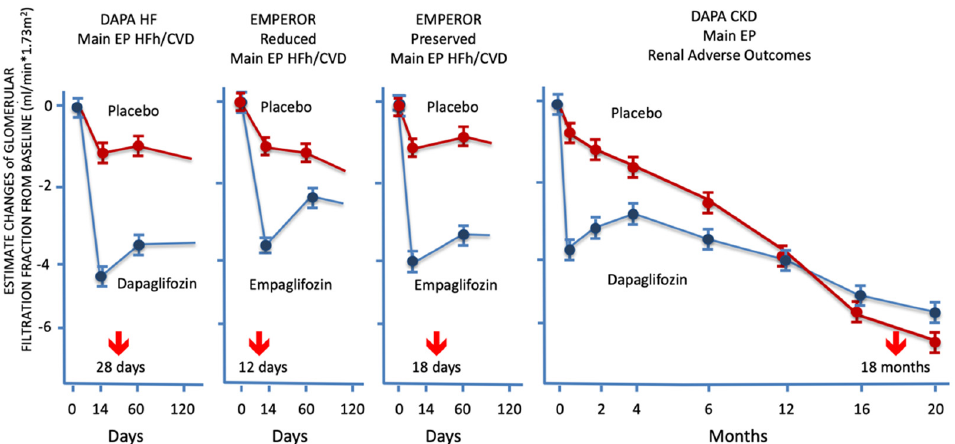
Figure 4. The figure depicts the temporal relationship between the detection of the statistically significant achievement of the primary end-point of DAPA HF [28], EMPEROR-Reduced [29], EMPEROR-Preserved [30], and DAPA CKD [22] studies and the glomerular filtration rate (GFR) dip occurrence after inhibition of sodium-glucose co-transporter-2. The significant decrease in the combined end-point of heart failure (HF) hospitalization or cardiovascular death was achieved in HF studies while the GFR dip was occurring, in a time window between two and four weeks from randomization. In those studies, the decline in HF exacerbations largely drove the therapeutic benefit. In the DAPA CKD, the decline in the primary end-point of renal adverse outcomes (RAO) started to appear after 6 months in the study follow-up, but statistical significance was achieved at 18-month follow-up. Of note, in all SGLT2is investigations, the decline in RAO was detected at a significant distance from the occurrence of GFR dip. See text for details. SGLT2 = sodium-glucose co-transporter-2; GFR = glomerular filtration rate; EP = end-point; HFh = heart failure hospitalization; CVD = cardiovascular